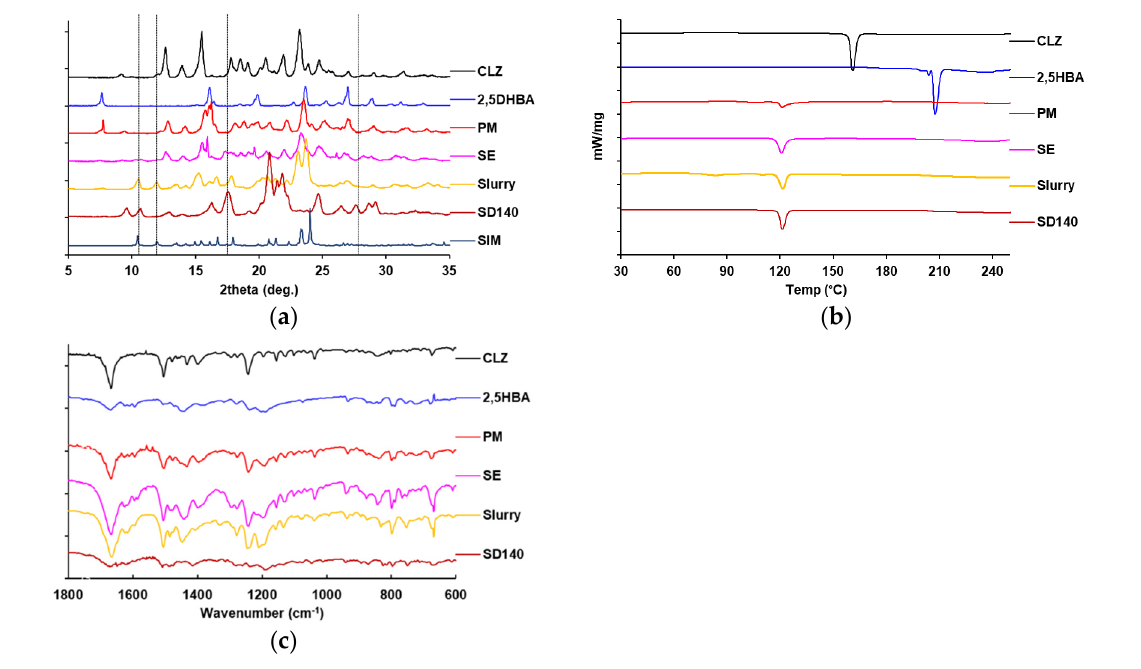
Figure 5. ( a ) PXRD, ( b ) DSC, and ( c ) FT-IR analysis of the CLZ-2,5DHBA cocrystals prepared using the solvent evaporation method, slurry method, or spray drying